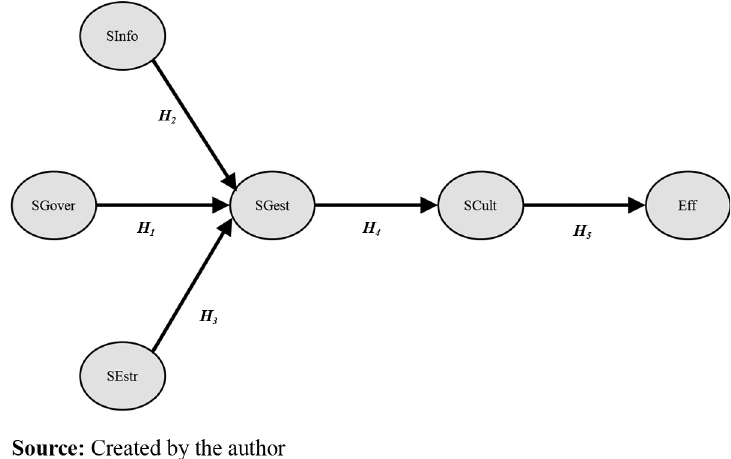
Figure 1. Theoretical